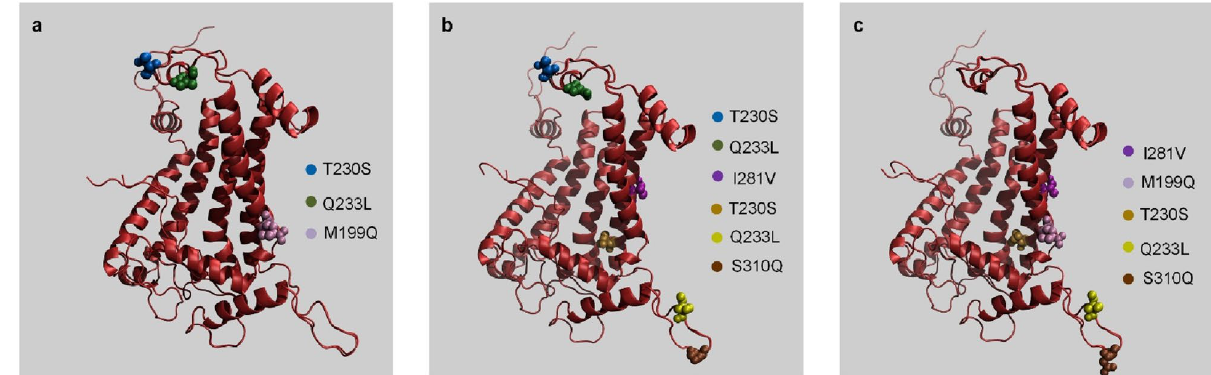
Figure 6. Non-synonymous sequence variants between the amino acid sequences from all three exposure conditions, overlaid on the respective predicted protein structures for the Photosystem II D1 (PsbA) protein. The marked locations represent the position of a non-synonymous variant between the sequences for the corresponding pair of conditions: ( a ) non-synonymous variants present in ISS/Dark but not ISS/UV conditions, ( b ) non-synonymous variants present in Ground/UV but not ISS/UV conditions, and ( c ) non-synonymous variants present in Ground/UV but not ISS/Dark conditions. ISS international space station, UV